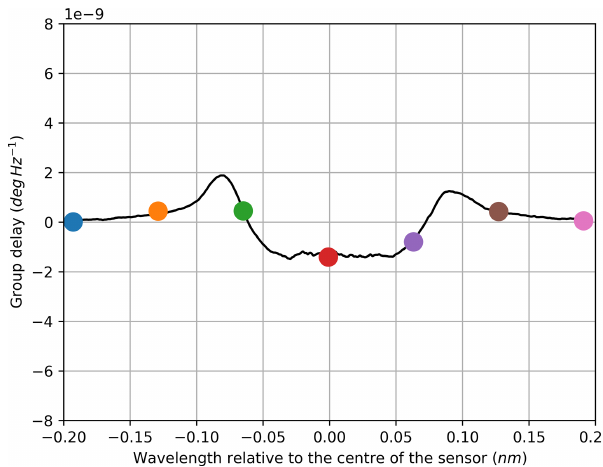
Figure 9. Group delay derived from the electrical phase of an FBG in transmission configuration.